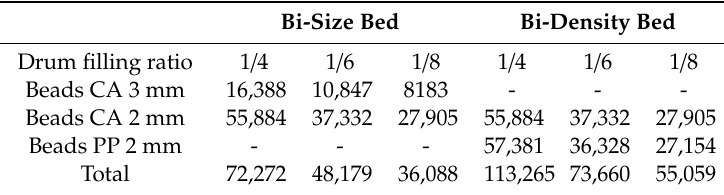
Table 1. Bed compositions for the experimental and simulated